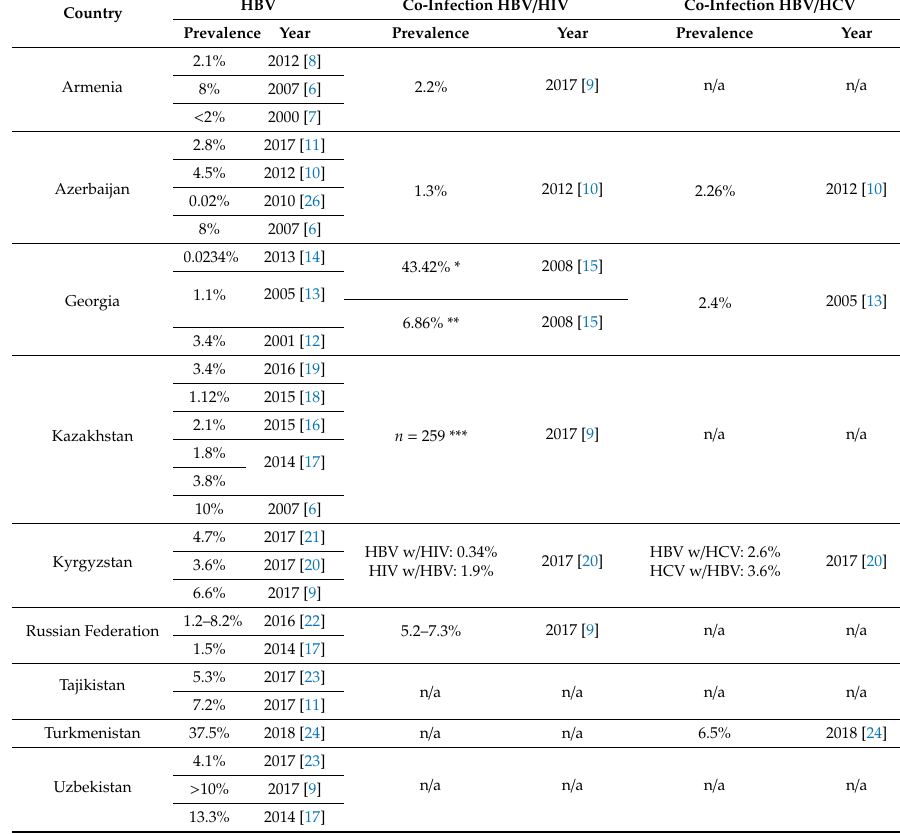
Table 1. Prevalence of HBV and co-infections of HBV / HIV and HBV / HCV. Prevalence of single and double infections, wherever available, is mentioned along with the source. In all the studies, prevalence was measured by the presence of hepatitis B surface antigen (HBsAg) in the blood. * Prevalence of anti-HBc antibodies in HIV-positive individuals. ** Prevalence of HBsAg in HIV-positive individuals. *** The source mentions the number of HBV / HIV infected patients without mentioning the sample size. n / a, not